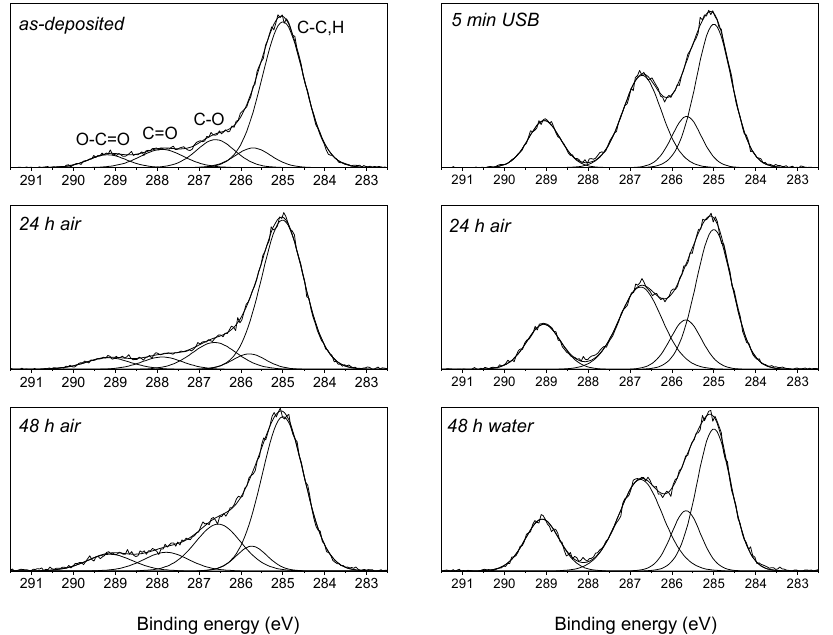
Figure 7. X-ray photoelectron spectroscopy (XPS) high-resolution C 1s spectra, including the peak-fit of HEMA-based polymer films as deposited after 5 min of USB, stored in air or in deionized water for 24 h and 48 h, respectively.